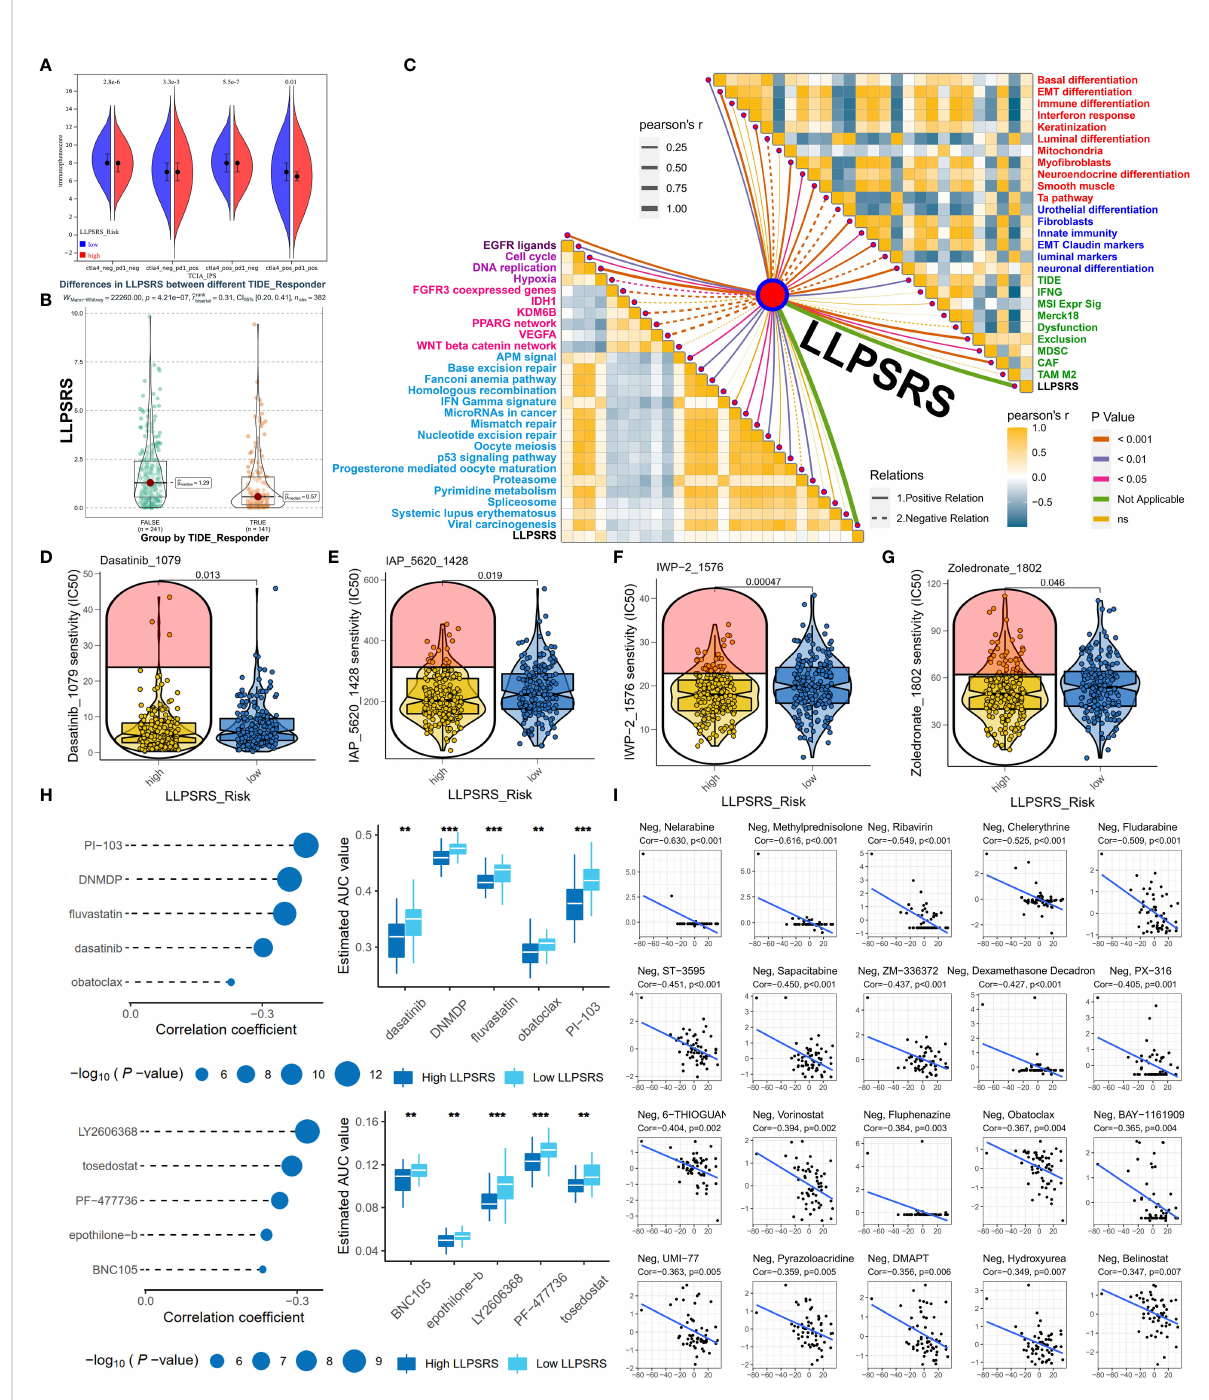
FIGURE 7 LLPSRS might be a promising biomarker to predict the ef fi cacy of adjuvant treatments. (A) Comparison of immunophenoscore between two subgroups. (B) Comparison of LLPSRS between responders and non-responders predicted by TIDE. (C) LLPSRS ’ s correlations with therapeutic signatures (EGFR ligands, deep purple; radiotherapy, purple; chemotherapy, magenta; irAEs, sky blue), 12 BLCA signatures (red), tumor progression biomarkers (blue), and additional output of TIDE platform (green). (D – G) Dasatinib, IAP_5620, IWP-2, and zoledronate showed lower IC50 value in high-risk subgroups via GDSC. (H) Five CTRP-related and fi ve PRISM-related compounds were identi fi ed by correlation between LLPSRS and AUC value. (I) Twenty CellMiner-related potential drugs for patients with higher LLPSRS were identi fi ed by correlation between LLPSRS and G150 value. The line in the box represents the median value, and the asterisks represent the p-value (**p< 0.01; ***p< 0.001); the statistical analyses were performed by the Mann – Whitney and Spearman ’ s correlation test. LLPSRS, liquid – liquid phase separation-related risk score; irAEs, immune-related adverse events; BLCA, bladder cancer; AUC, area under the receiver operating characteristic